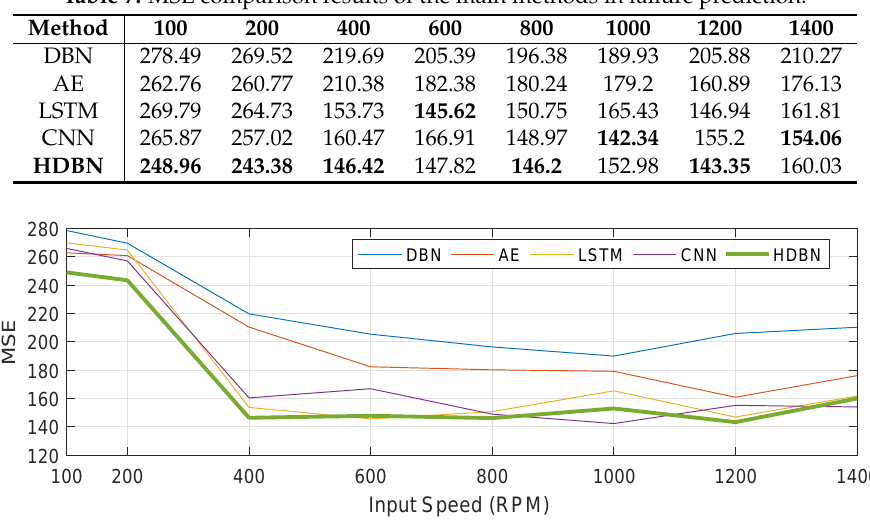
Table 7. MSE comparison results of the main methods in failure prediction.